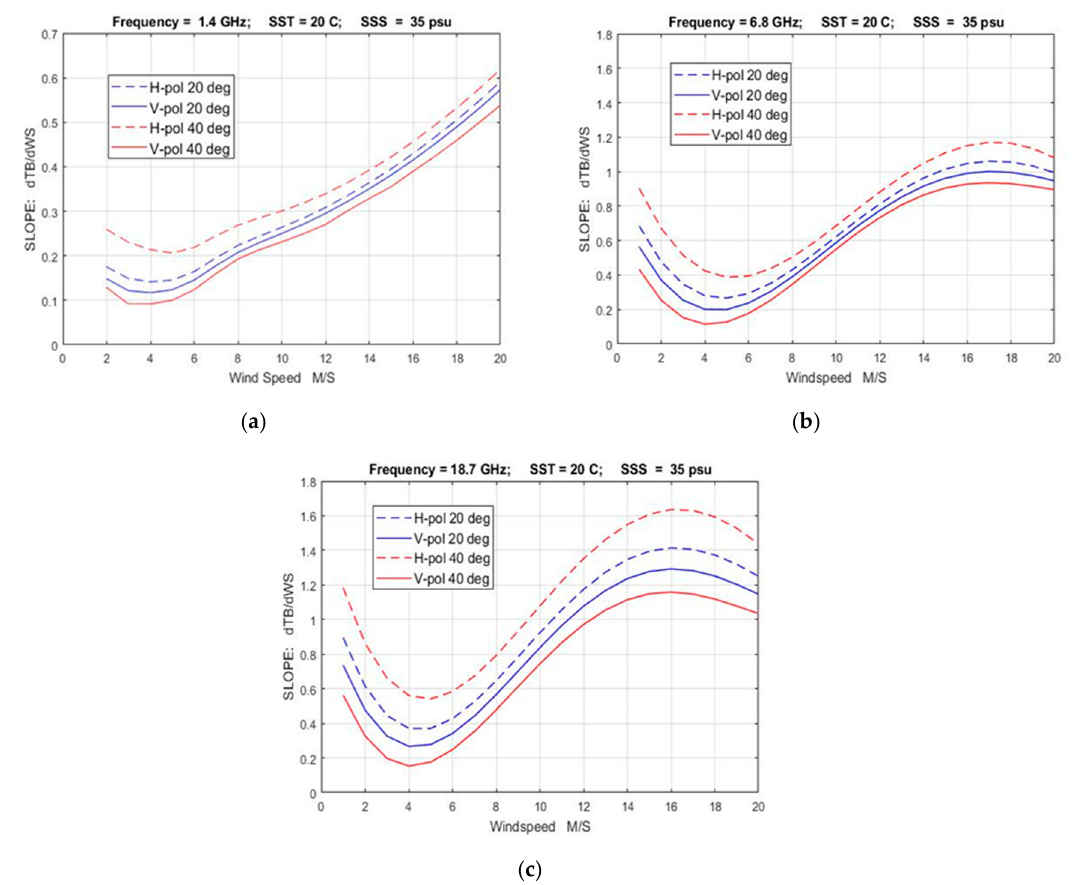
Figure 11. Sensitivity, dTB / dWS, of brightness temperature to a change in wind speed for incidence angles of 20 o and 40 ° and SST = 20 ℃ ; SSS = 35 psu: ( a ) 1.4 GHz; ( b ) 6.8 GHz; ( c ) 18.7 GHz.